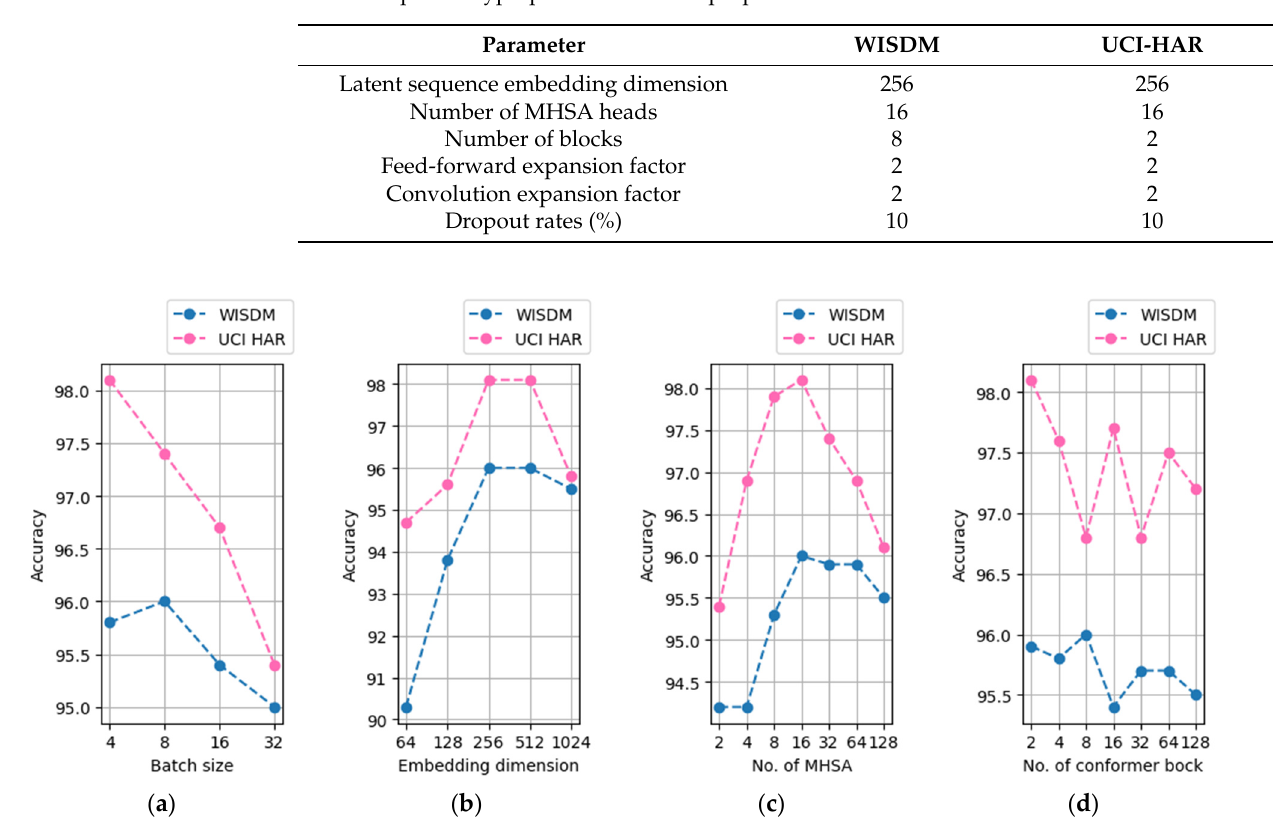
Table 1. Optimal hyperparameters of the proposed model.